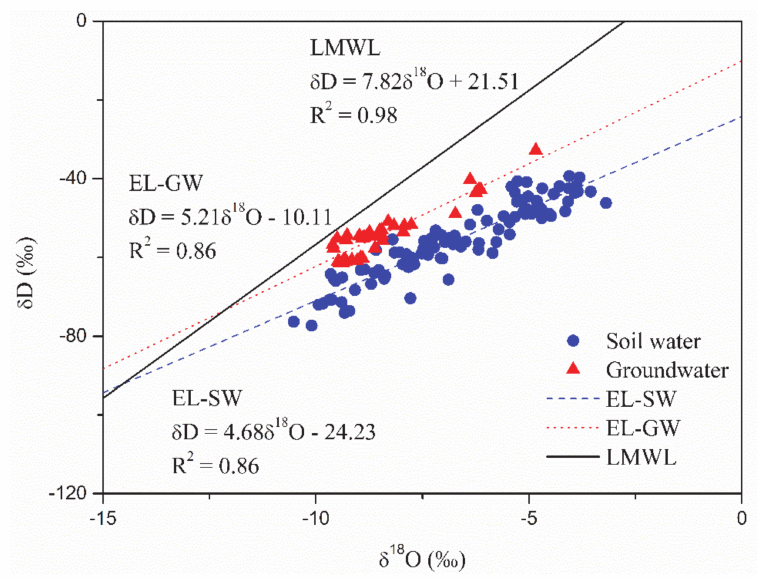
Figure 6. Relationship between δ D and δ 18 O of soil water, groundwater, and precipitation. The evaporation line of soil water (EL-SW), evaporation line of groundwater (EL-GW), and local meteoric water line (LMWL) are shown for